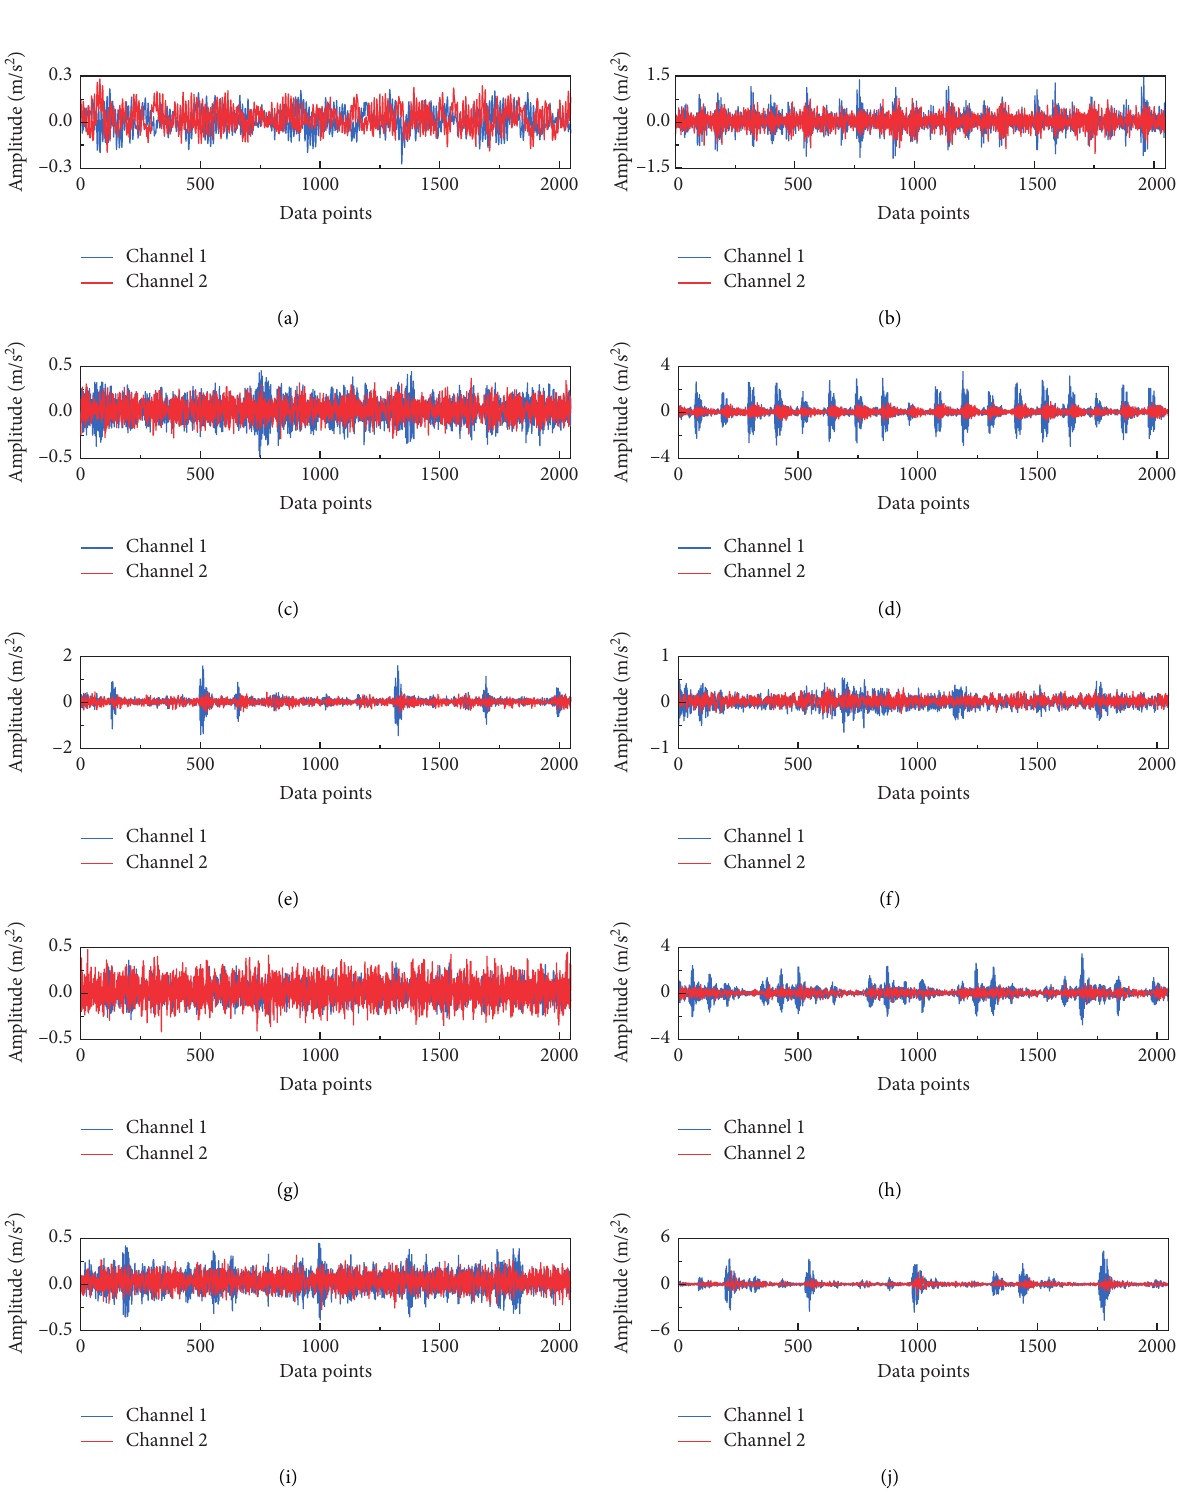
Figure 11: Parts of original vibration signal of bearings. (a) Normal. (b) IRF1. (c) BF1. (d) ORF1. (e) IRF1. (f) BF2. (g) ORF2. (h) IRF3. (i) RF3. (j)